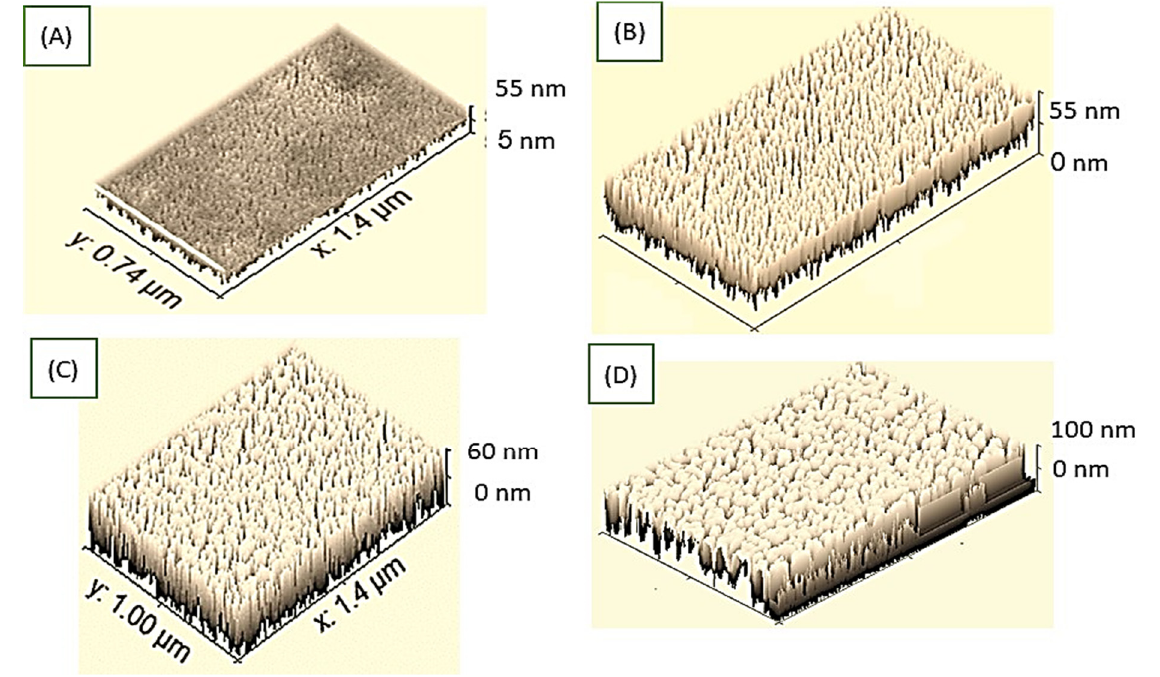
Figure 4. Roughness and cross-section using Image J program for PMT after Au coating for the times of ( A ) 0, ( B ) 1, ( C ) 2, and ( D ) 3 min.